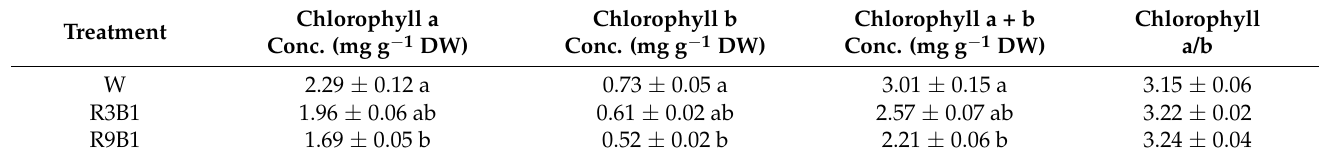
Table 10. Effect of light quality on chlorophyll concentration (conc.) of leaves in ‘Micro-Tom’ 10 DAT in Experiment 2. DW (g) is dry weight. Each value represents the mean ± standard error. Different letters in a column indicate significant differences among the treatments based on Tukey − Kramer’s test at p < 0.05 ( n = 4). The PPFD of three treatments was set at 300 µ mol m − 2 s − 1 . W: white light; R3B1: red/blue ratio = 3; R9B1: red/blue ratio = 9.